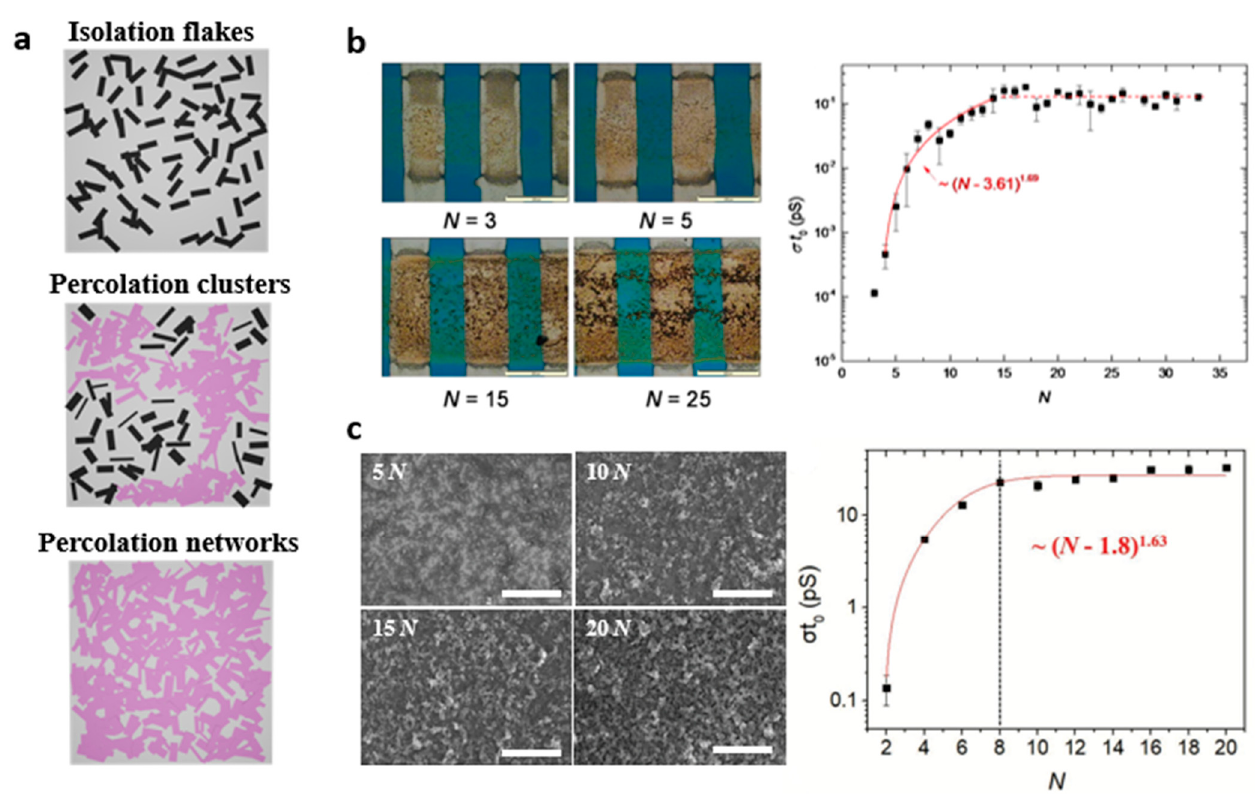
Figure 9. ( a ) Schematic of percolation theory: isolation flakes, percolation clusters, percolation networks. ( b ) Optical micrograph of the printed MoS 2 transistors on Si/SiO 2 wafers with different printing passes N; conductivity variation of the printed BP films with respect to N. Reprinted with permission from Ref. [36] . Copyright 2014 John Wiley and Sons. ( c ) SEM images of BP films printed at 5 N, 10 N, 15 N, and 20 N (Scale bar = 10 μ m); conductivity variation of the printed BP films with respect to N. Reprinted with permission from Ref. [22] . Copyright 2021 John Wiley and Sons.